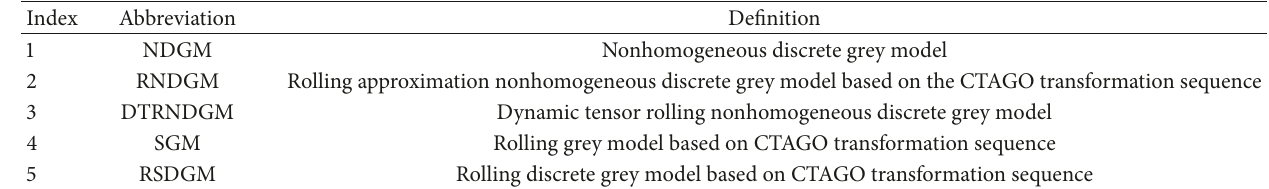
Table 1: Abbreviations and corresponding definitions for grey prediction